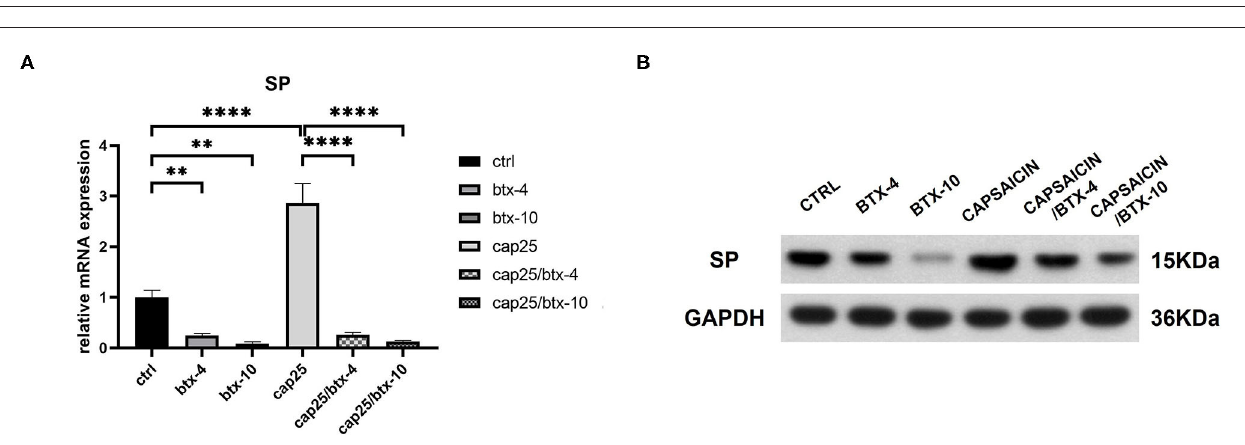
FIGURE 3 | The mRNA and protein expressions were from hypertrophic scar-derived fibroblasts treated with increasing concentrations of SP. (A) Relative mRNA expression of NK-1R 2h after treatment with 1, 10, and 100ng/ml of SP; (B) Relative mRNA expression of type 1 collagen 2h after treatment with 1, 10, and 100ng/mL of SP; (C) Relative mRNA expression of type 3 collagen 2h after treatment with 1, 10, and 100ng/mL of SP (ANOVA showed no significance); (D) Expression of NK-1R, type 1 and 3 collagen 2h after treatment with 1, 10, and 100ng/mL of SP detected by western blot analysis; (E) Relative mRNA expression of NK-1R 4h after treatment with 1, 10, and 100ng/mL of SP; (F) Relative mRNA expression of type 1 collagen 4h after treatment with 1, 10, and 100ng/mL of SP; (G) Relative mRNA expression of type 3 collagen 4h after treatment with 1, 10, and 100ng/mL of SP (ANOVA showed no significance); (H) Expression of NK-1R, type 1 and 3 collagen 4h after treatment with 1, 10, and 100ng/mL of SP detected by western blot analysis. The results are represented as the mean of 3 experiments ± SD, which were performed in duplicate for each experimental condition (** P < 0.01; *** P < 0.001; **** P < 0.0001).